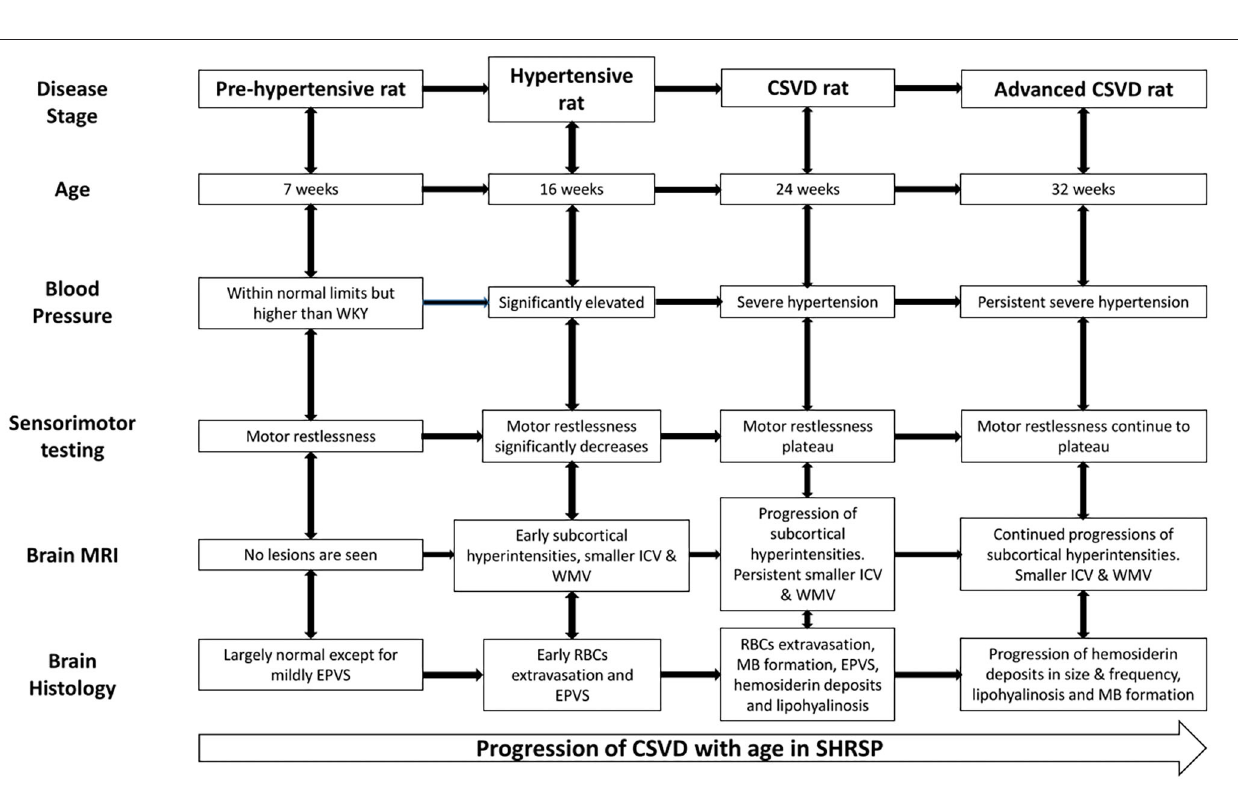
FIGURE 7 | (D) ]. The percentage of SHRSP at study time points with each of CSVD lesions are shown in (E) . (F) Demonstrates the progression of these lesions across age. These results demonstrate that EPVS. are early findings while hemosiderin deposition occur later in life. SHRSP, spontaneously hypertensive stroke-prone rats; EPVS, enlarged perivascular spaces; MB, microbleed; Wks, weeks.